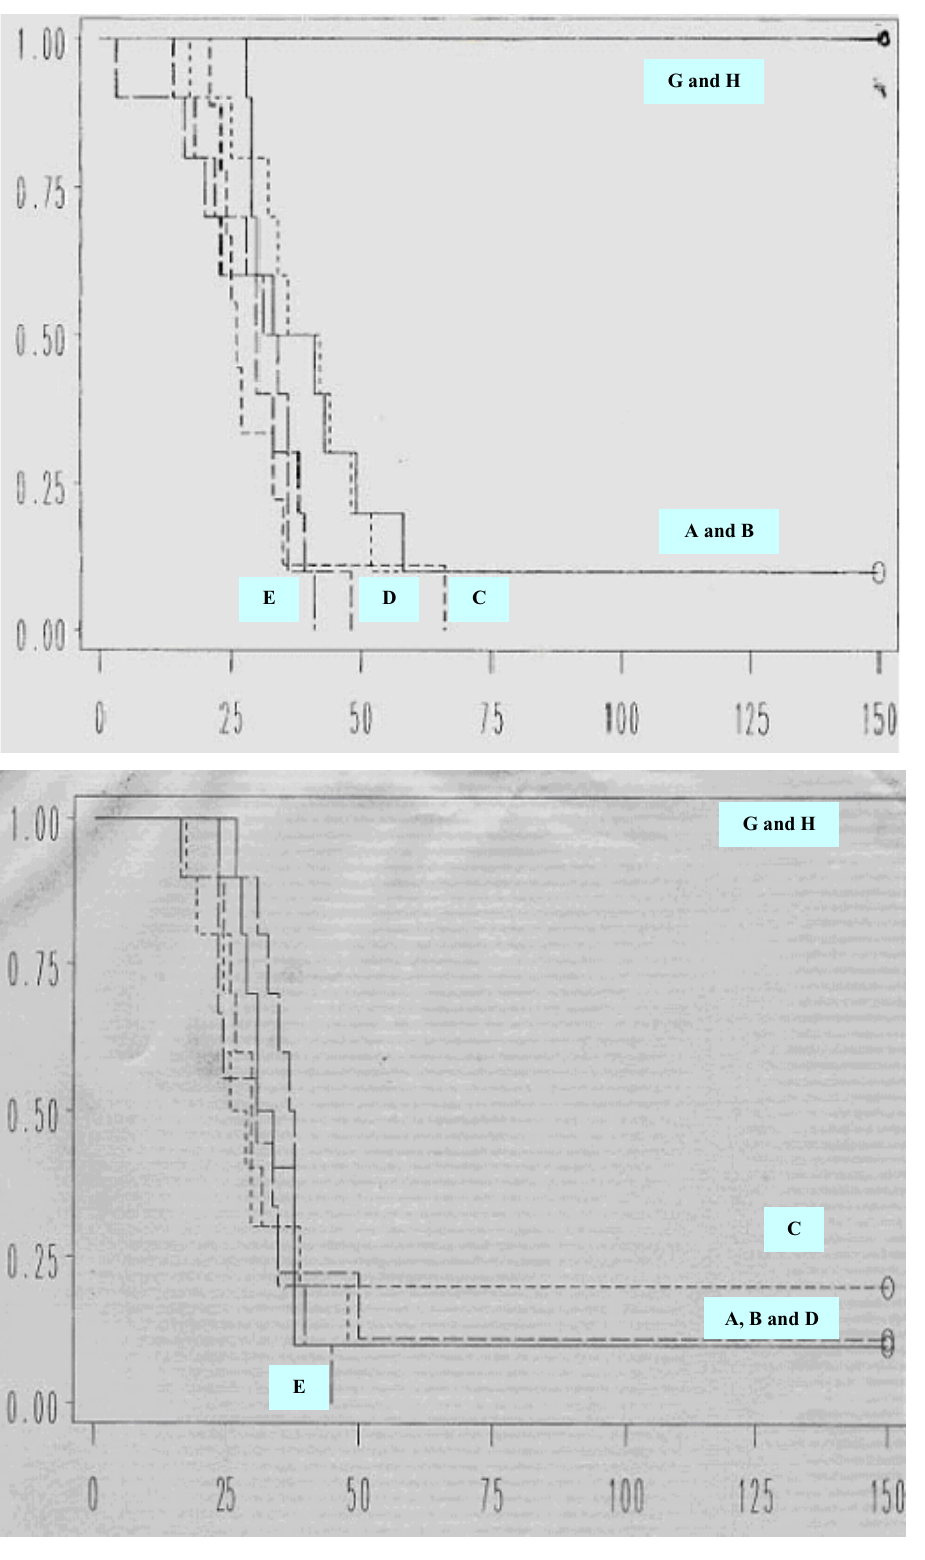
Figure 4. Survival distribution function curves of animals injected with LQQ venom (300 (cid:80) g.kg -1 , s.c.) and verapamil at a dose of either ( I ) 0.03 mg.kg -1 or ( II ) 0.1 mg.kg -1 . The Y-axis represents survival distribution, with (0) indicating death and (1) survival, while the X-axis represents survival time in minutes. ( A ) LQQ venom alone, ( B ) V administered 3 min before, ( C ) 1 min, ( D ) 5 min, and ( E ) 15 min after LQQ venom. As control, ( G ) V and ( H ) 0.9%NaCl were administered